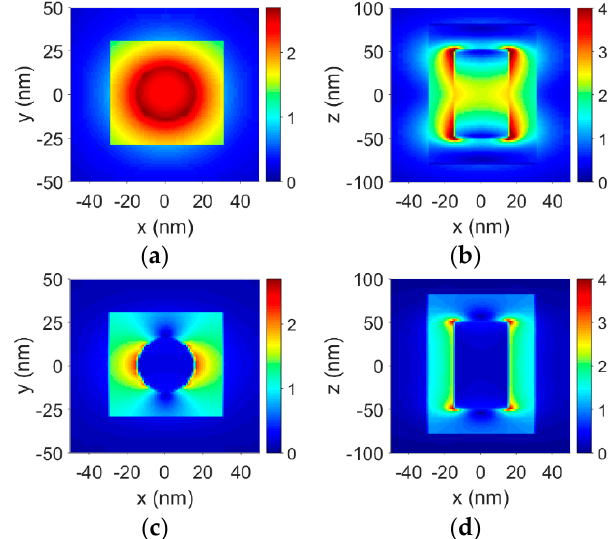
Figure 4. The electric field distributions of the silver nanorod with a diameter of 30 nm and a length of 100 nm. ( a ) and ( b ) represent the electric field profiles of E(x, y) and E(x, z) at 517 nm for the TE polarization in terms of a 2D z-normal monitor (z = 0) and a 2D y-normal monitor (y = 0), respectively; ( c ) and ( d ) correspond to the electric field profiles of E(x, y) and E(x, z) at 517 nm for the TM polarization based on a 2D z-normal monitor (z = 0) and a 2D y-normal monitor (y = 0), respectively.